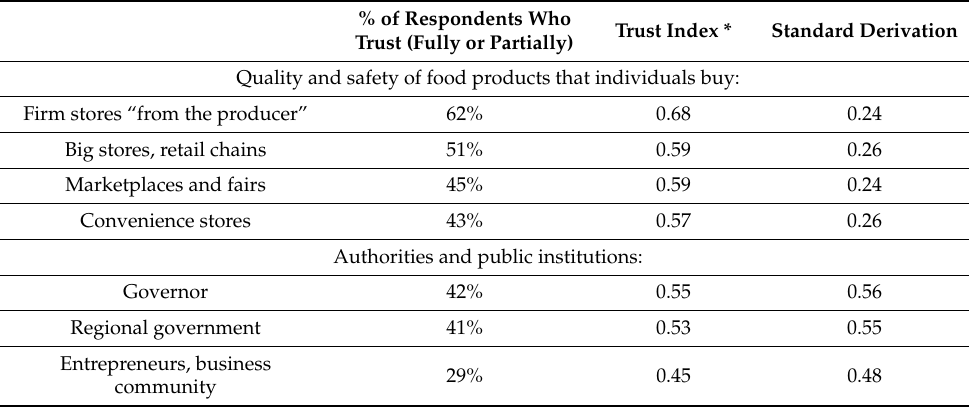
Table 1. Level of trust in quality and safety of food people buy in different outlets. Answer question 1–Q1 (see Materials and Methods